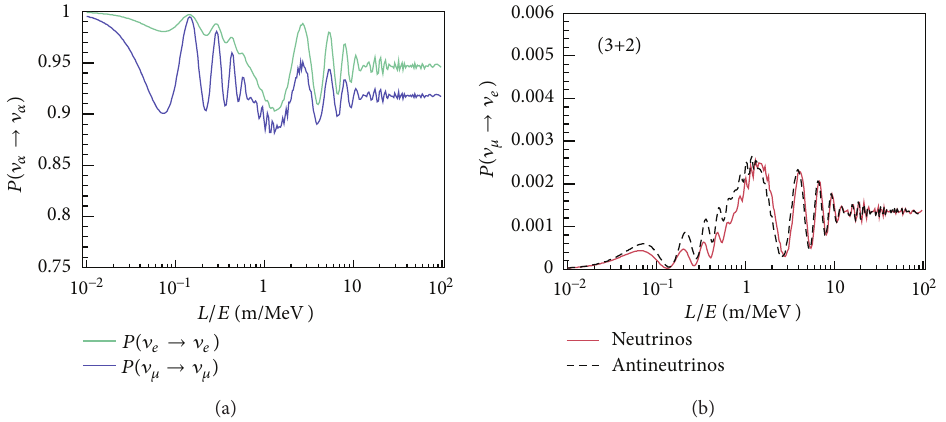
Figure 15: The ( 3 + 2 ) oscillation probabilities for the global best-fit (“all” datasets) values in Table 3 with 10% resolution in 𝐿/𝐸